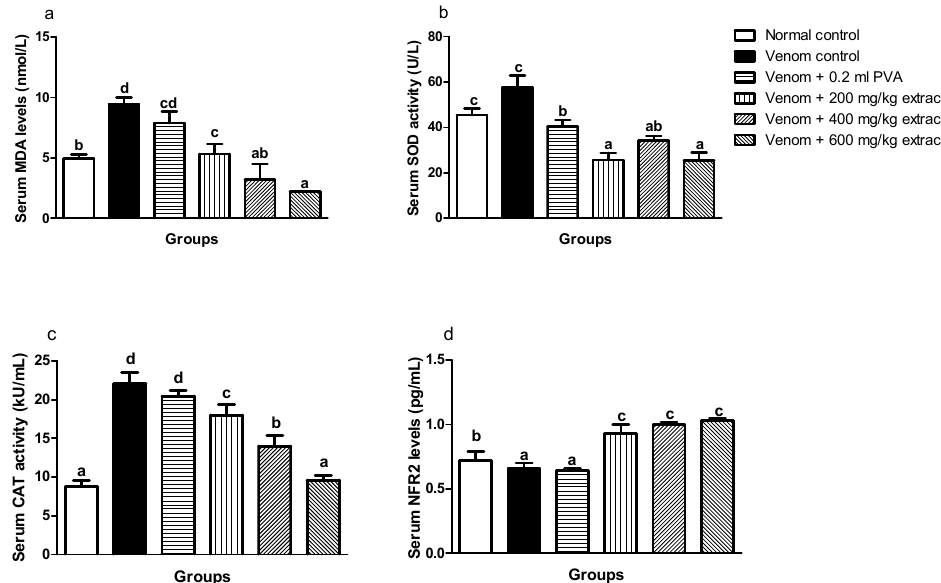
Figure 2. Effects of M. oleifera extract on MDA ( a ), SOD ( b ), and CAT ( c ) activities, and Nrf2 levels ( d ) in the sera of rats challenged with E. ocellatus venom. Data are expressed as mean ± SD ( n = 3). Bars with different letters are statistically distinct ( p < 0.05). PVA: polyvalent antivenom;